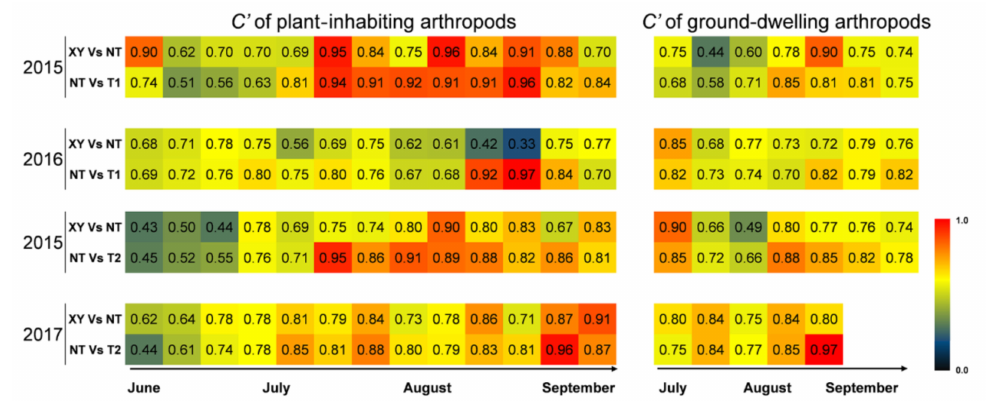
Figure 5. Heat maps of the community similarity index ( C (cid:48) ) of arthropods in the plots of cultivated variety XianYu335 (XY), non-transgenic recipient variety DBN318 (NT), transgenic maize DBN9868 (T1) and DBN9936 (T2) from 2015 to 2017. Blue indicates a low value (0.0) of the community similarity index and red indicates a high value